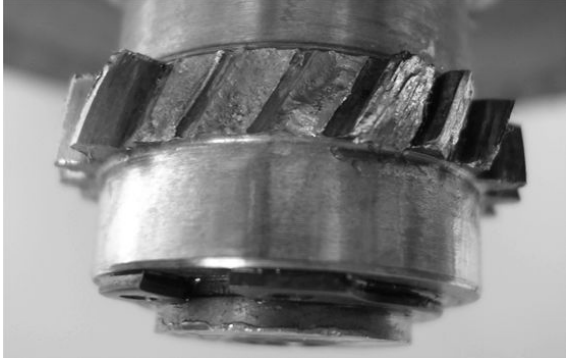
Fig. 5. Resulting fatigue damage on the test gear.